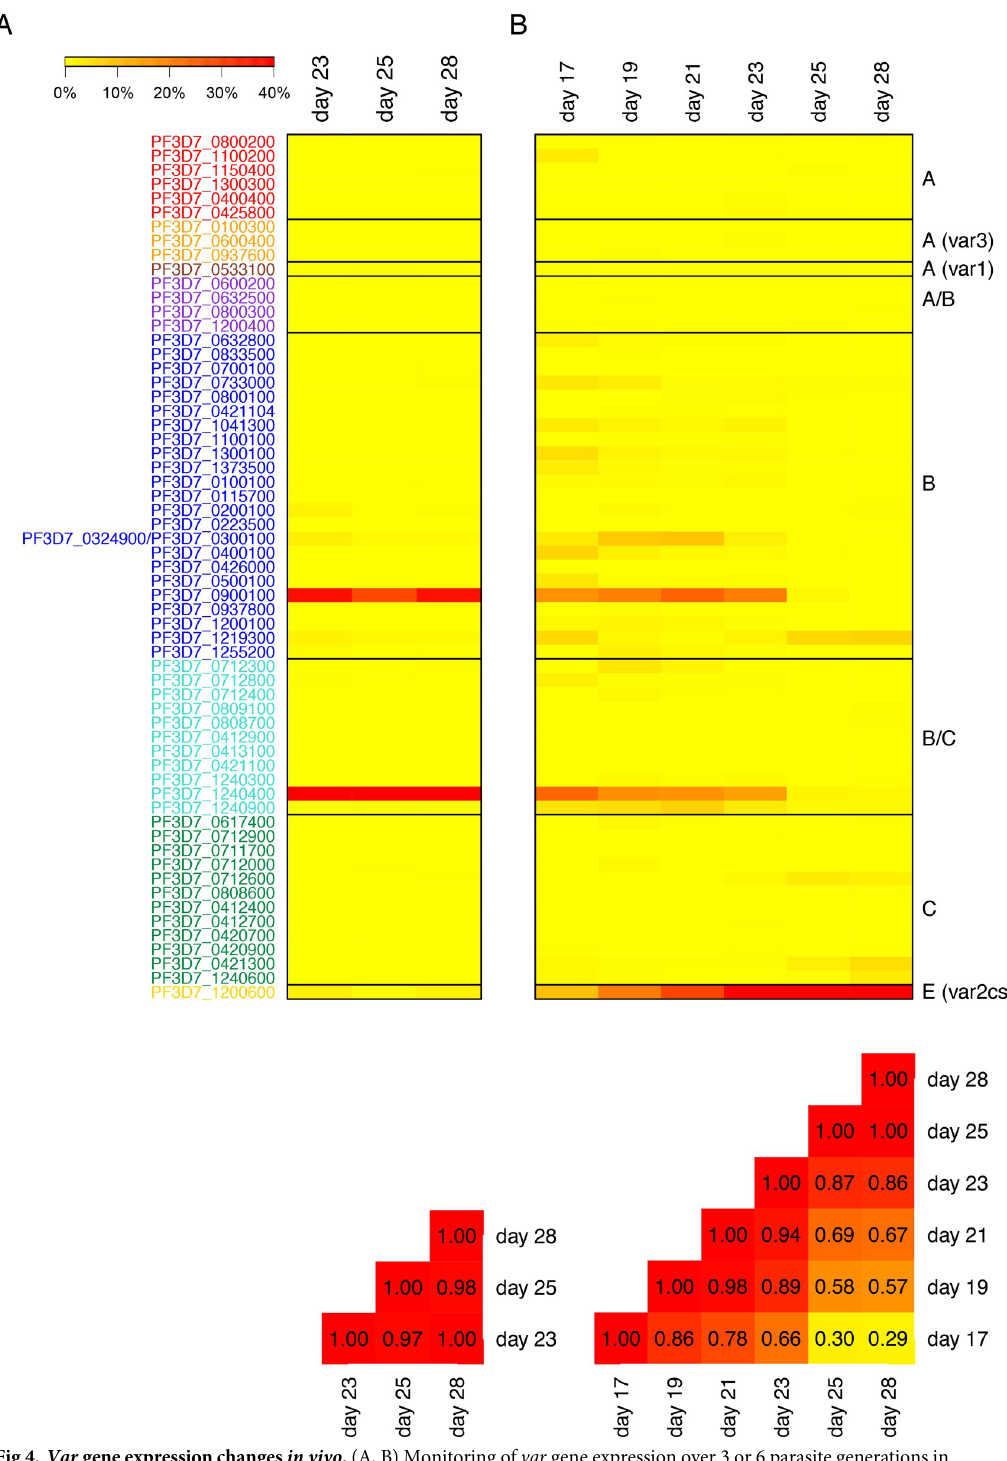
PLOS Pathogens| https://doi.org/10.1371/journal.ppat.1007906 July 11,